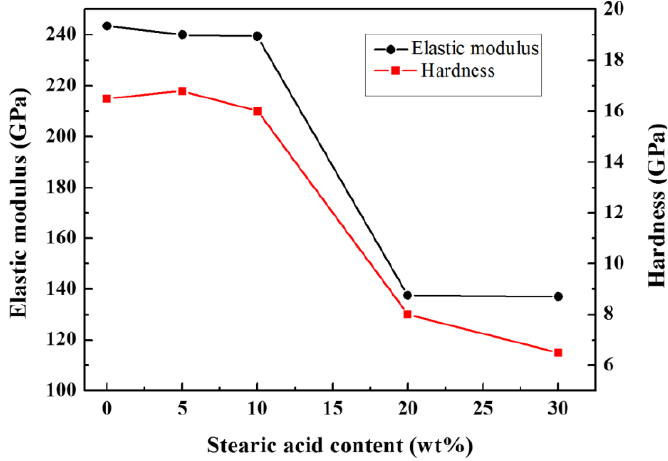
Figure 4. The hardness and elastic modulus of samples with different stearic acid contents.